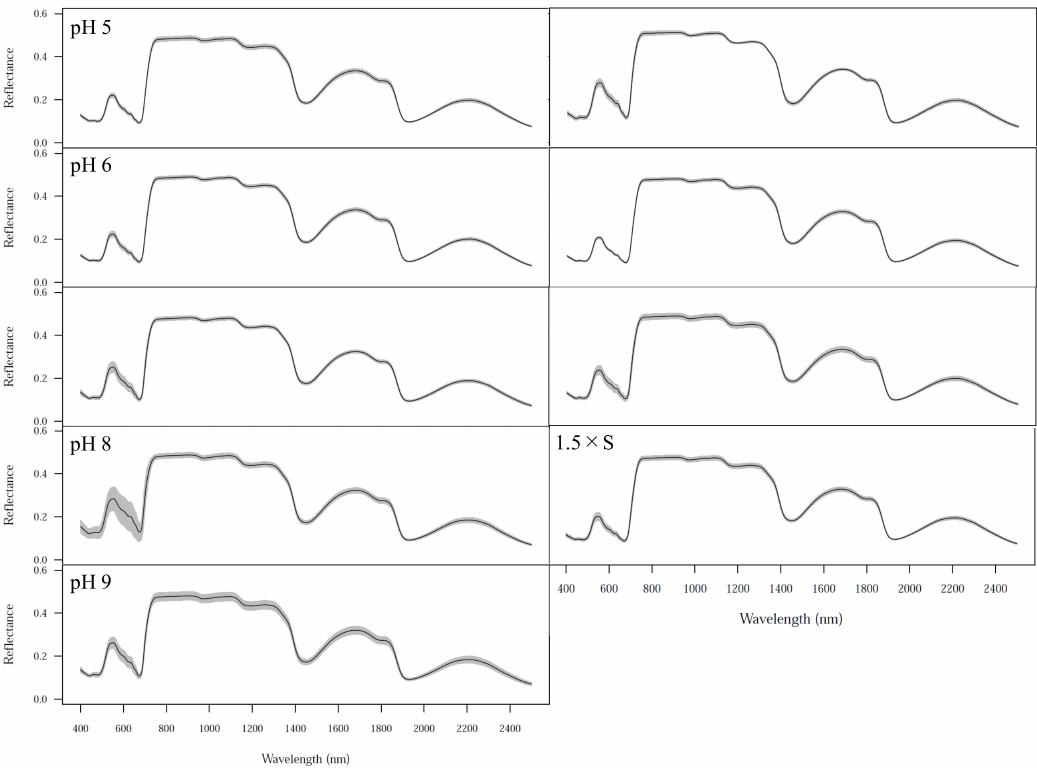
Figure 4. Mean reflectance spectra (solid lines) and standard deviations (thinner zones) for the di ff erent pH conditions or S-strength treatments. The shifts of the green peak and the red edge inflexion point were confirmed within the pH conditions or S strengths. Mean reflectance spectra and standard deviations are also provided as Supplementary